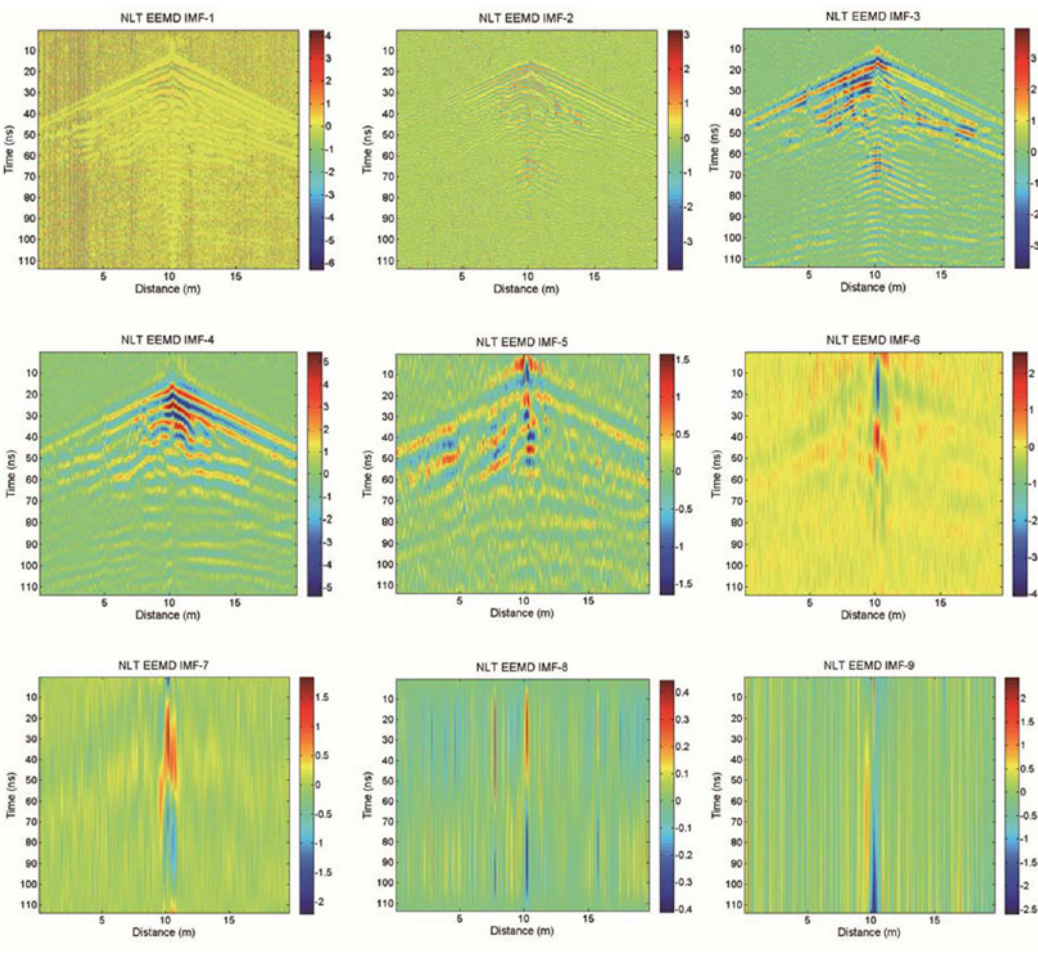
Fig. 12. Filter bank of the GPR shot gather data with logarithmic transform.